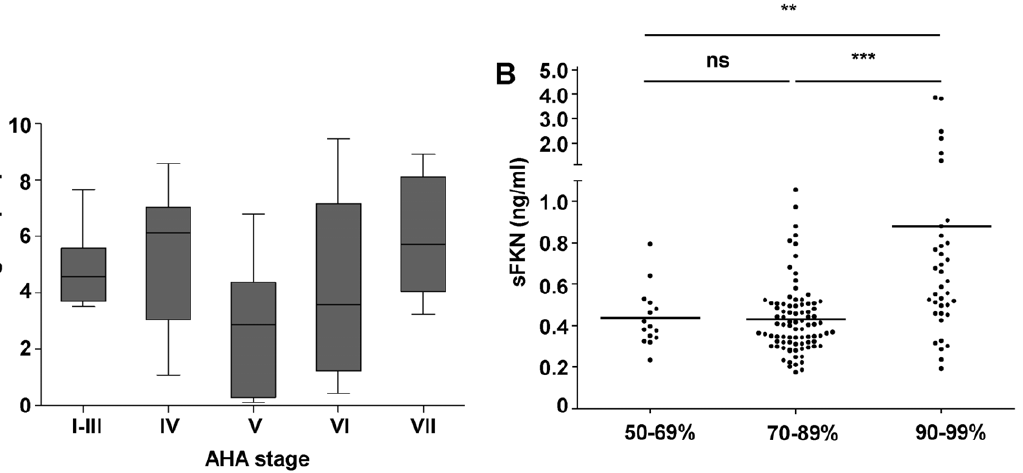
Figure 4. Quantitative analysis of FKN expression and FKN serum levels. (A) PCR analysis of FKN expression in atherosclerotic plaques of different AHA stages. Graph indicates relative expression ratio as calculated from the real-time PCR efficiencies and the crossing point deviation of FKN versus control. Mean FKN expression per gram plaque tissue did not differ significantly between AHA stages I–VI. (B) Serum levels of sFKN in 10 patients with moderate (50–69%), 83 with advanced (70–89%), and 44 with subocclusive (90–99%) carotid artery stenosis. Patients with subocclusive stenosis showed significantly higher levels of sFKN. **p , 0.001 for 50–69% vs. 90–99% (0.44 6 0.04 ng/ml vs. 0.88 6 0.14 ng/ml). ***p , 0.0001 for 70– 89% vs. 90–99% (0.43 6 0.02 ng/ml vs. 0.88 6 0.14 ng/ml). p=ns for 50–69% vs. 70–89%.